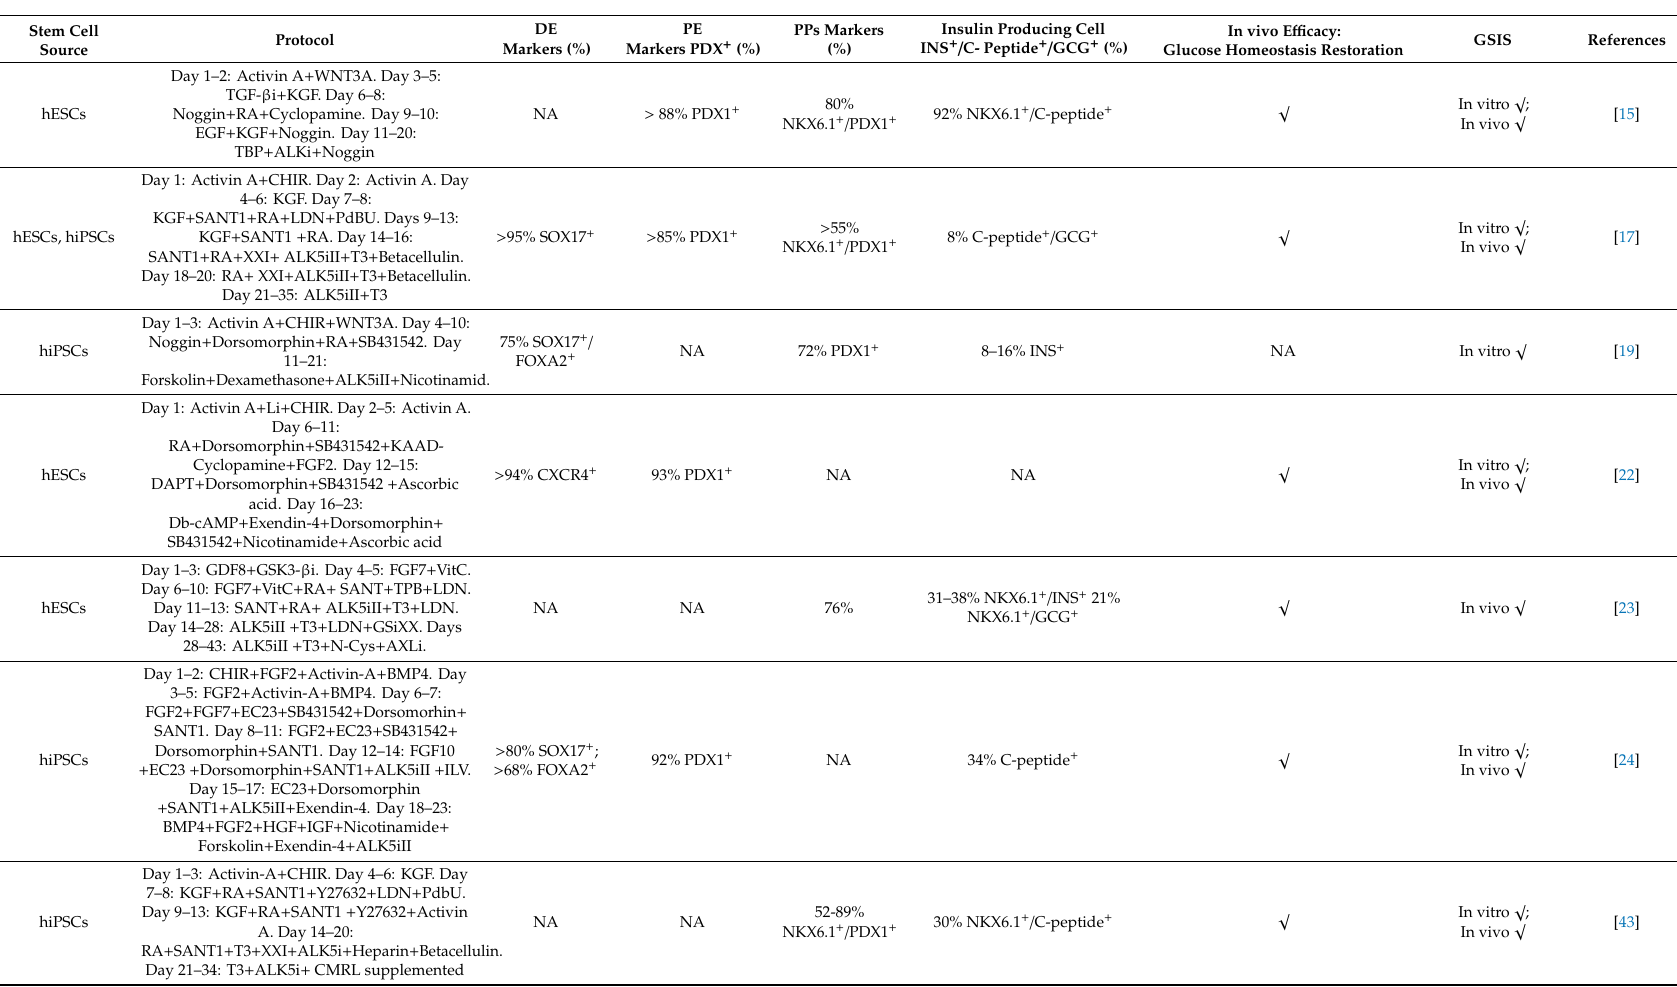
Table 1. Overview of small molecules involved in the development process and showing the functionality of β -like cell-derived from various sources of stem cells. Stem Cell